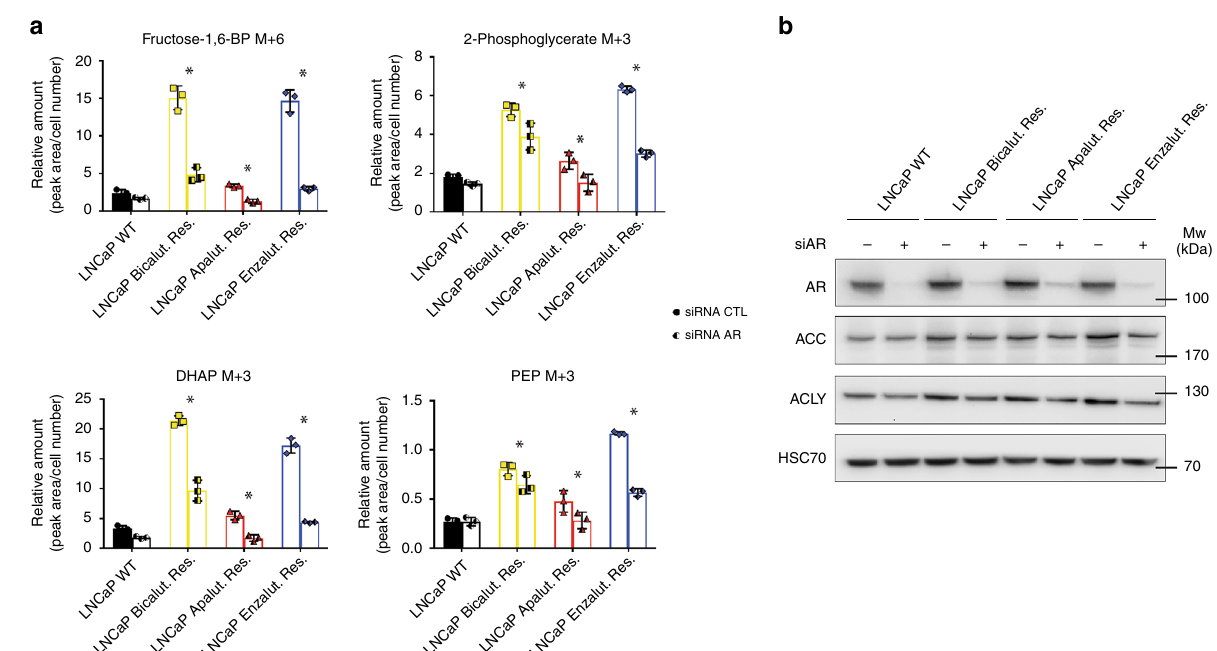
Fig. 4 Increased glucose metabolism in ARI-resistant cells depends on AR signalling. a Expression of labelled isotopologue of selected metabolites in ARI-resistant and WT LNCaP cells silenced for AR and following 1 h 13 C-glucose incorporation. b Western blot analysis of AR, ACC and ACLY expression in WT and ARI-resistant LNCaP cells following AR siRNA silencing. HSC70 is used as a sample loading control. a Data are presented as mean values + / − SD, * p -value of labelled fraction < 0.05 using a 2-way ANOVA with a Sidak ’ s multiple comparisons test. DHAP dihydroxyacetone-phosphate, PEP phosphoenolpyruvate. Source data are provided as a Source data